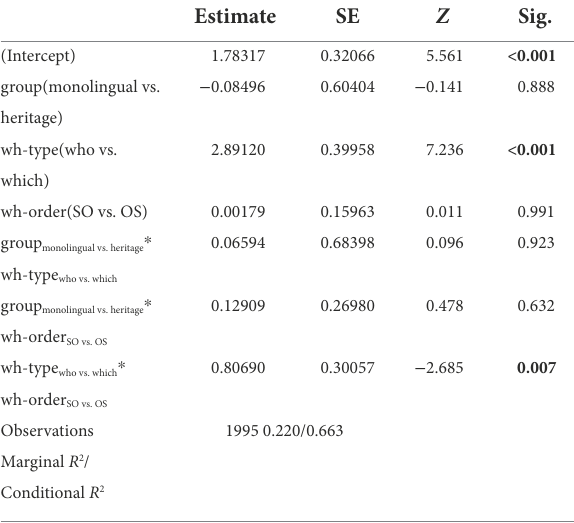
TABLE 3 Model summary for comprehension accuracy of multiple